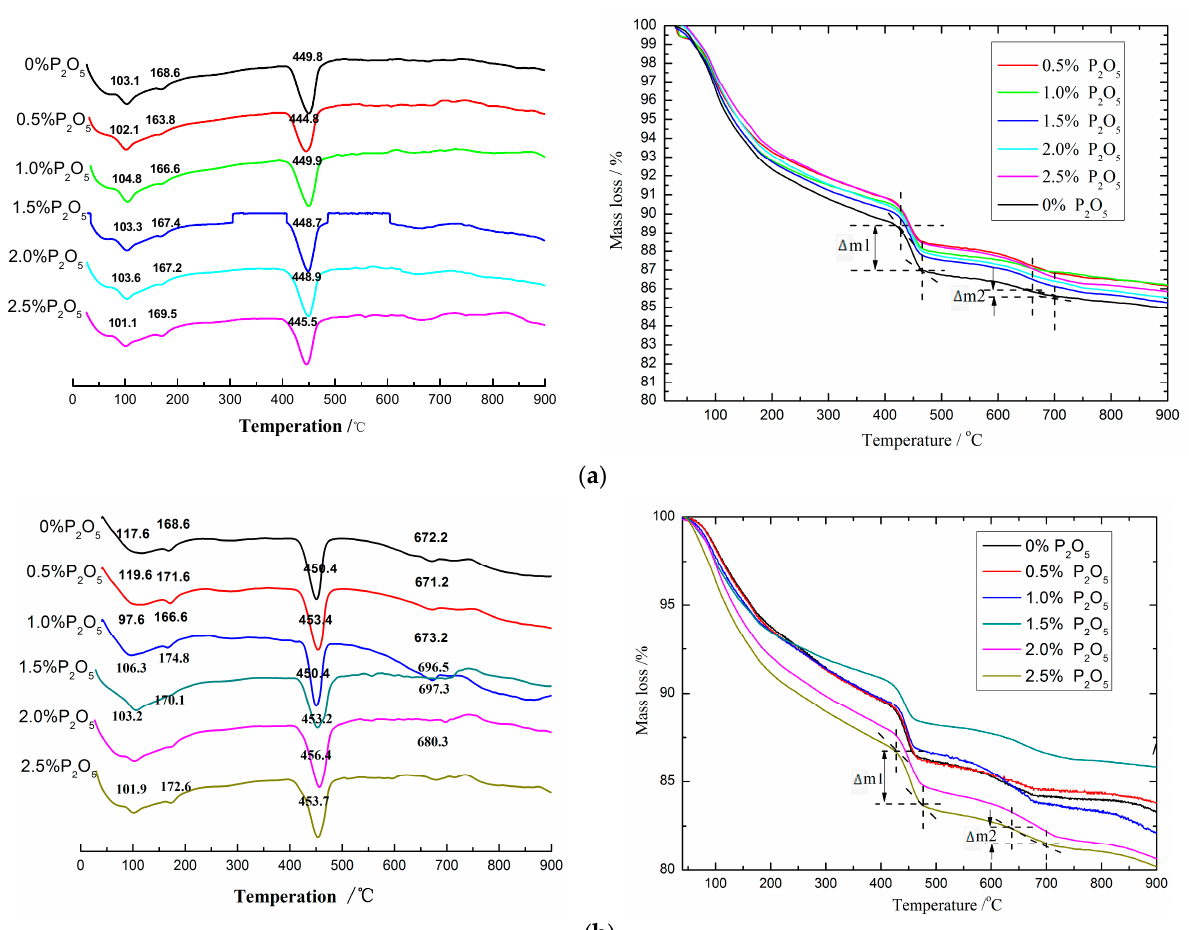
Figure 7. DSC-TG of cement pastes hydrated for ( a ) 3 days and ( b ) 28 days. Based on the results of TG-DSC, the contents of CH in those samples were calculated by Equation (1). However, accounting for the effective amount of C 3 S and C 2 S whose main hydration products were CH, the normalized value of CH by C 3 S and C 2 S is presented in Figure 8. As mentioned before [24–26], because of the mineralization caused by the low dosage of fluorapatite (0.5% P 2 O 5 ), compared to the controlling sample, a slight increase can be detected after curing for 3 days. However, when the content of P 2 O 5 increases to 1.0%, a sudden decrease for CH happens, by 6.5% compared to the plain sample. In addition, when the content of P 2 O 5 was higher than 1.0%, the CH fluctuated around 18%. Then, after curing for 28 days, except for the 0.5% P 2 O 5 whose mineralization effect makes CH suffer a slight increase, the continuous increase in the amount of P 2 O 5 causes a corresponding drop in CH. The results showed that when the content of P 2 O 5 was 2.5%, the amount of CH at 28 days decreased by 12.1% in contrast to the controlling sample, which matched the development of the compressive strength of cement pastes well, both at 3 and at 28 days.